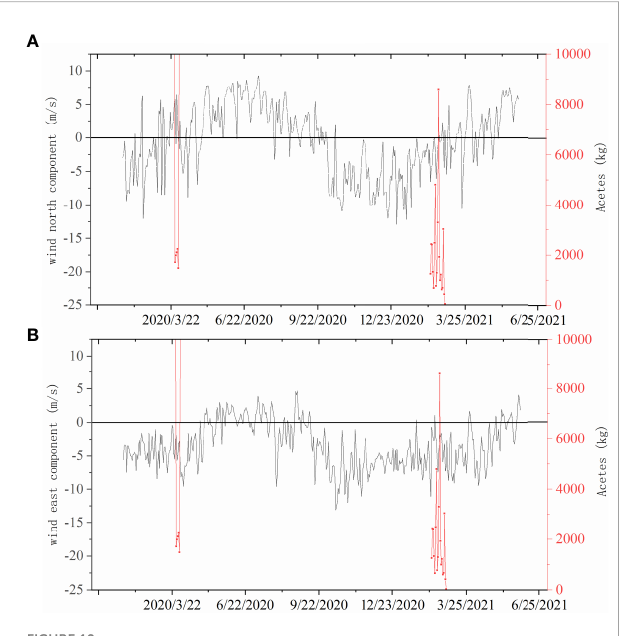
FIGURE 10 Association between wind and the Acetes catch. (A) The wind north component. (B) The wind east